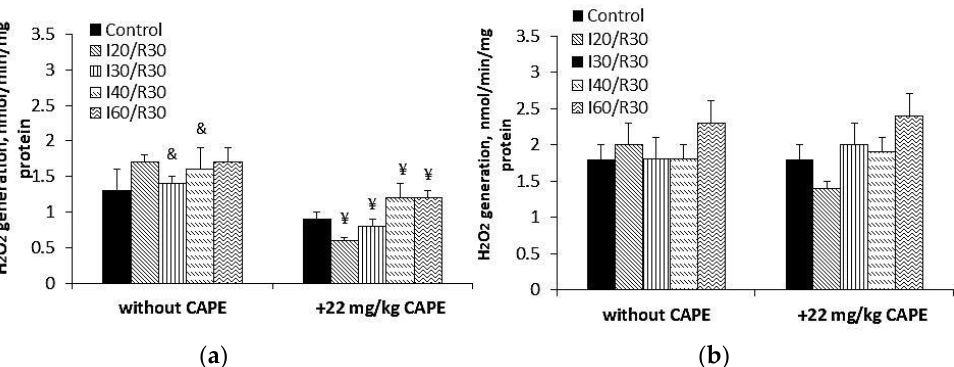
Figure 11. Effect of ischemia and CAPE on H 2 O 2 generation in the kidney mitochondria. The generation of H 2 O 2 in the kidney mitochondria was determined fluorimetrically, as described in the Materials and Methods section (excitation at 544 nm, emission at 590 nm), in the presence of 0.4 mM substrate succinate, the Complex I inhibitor rotenone (5 µ M), and the Complex III inhibitor myxothiazole (2 µ M). Complex II (SDH)-specific F and Q site inhibitors were added to the appropriate wells: The F site inhibitor malonate ( a ) and the Q site inhibitor atpenin A5 ( b ). & p < 0.05 vs. the 0.4 mM succinate group in the presence of the Complex I inhibitor rotenone (5 µ M) and the Complex III inhibitor myxothiazole (2 µ M) (Figure 12a, without CAPE); ¥ p < 0.05 vs. the group without CAPE. One-way ANOVA followed by a Fisher’s LSD post hoc test were used to compare the effects.